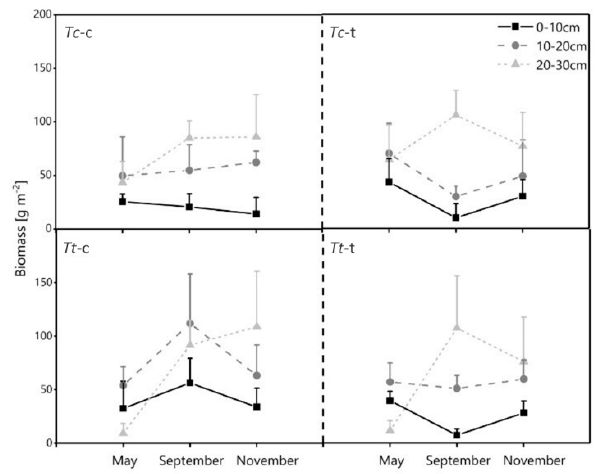
Figure 7. Fine root biomass (g m − 2 ) in the three layers of 0–10, 10–20, and 20–30 cm of the control and drought treatment groups of T. cordata and T. tomentosa in May, September, and November 2017. Values denote the average of all trees per cultivar and group ± the standard deviation.